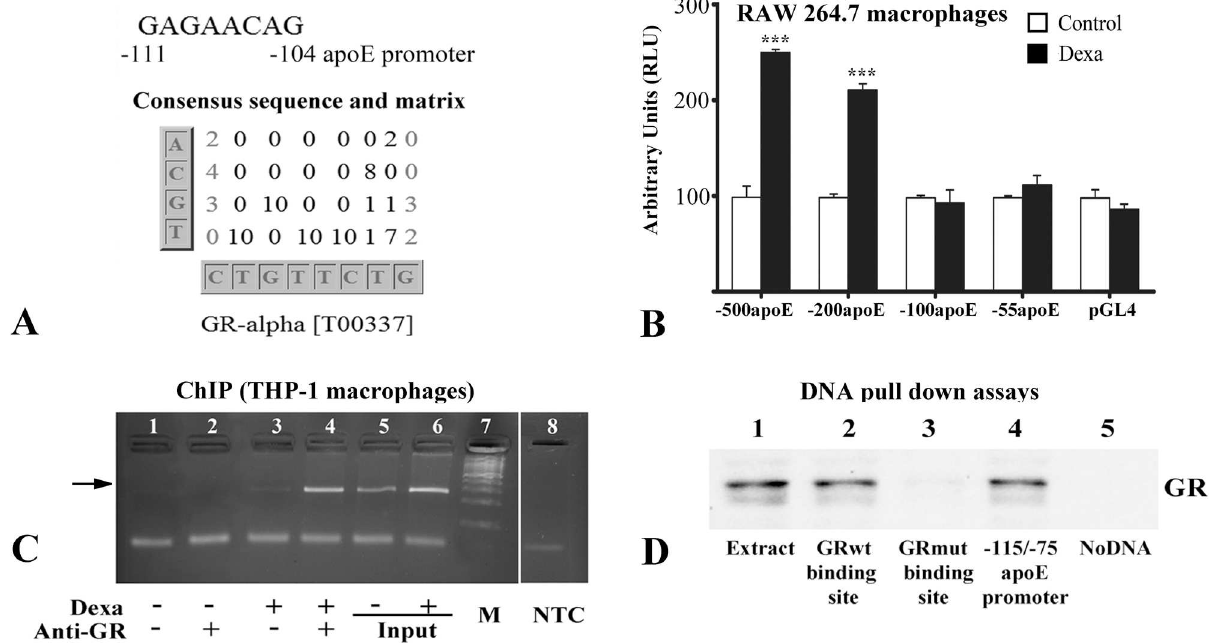
Fig 6. In macrophages glucocorticoid receptors (GRs) bind to a consensus sequence in apoE proximal promoter and upregulate its activity. (A) In silico analysisof apoE proximalpromoter revealing a GR α bindingsite in the region-111 ! -104.(B) In transiently transfected RAW 264.7 macrophages, dexamethasone significantly enhances the activity of [-500/+73] apoE promoterand of the [-200/+73] fragment, but not the activities of the [-100/+73] and [-55/+73] deletionfragments or the activity of the pGL4 vector. (C) Chromatin immunoprecipitationassay shows that GR proteins are recruited to the humanapoE promoter in PMA-differentiatedTHP1 macrophages treated with dexamethasone (lane 4). No bands were observed in untreated macrophages (lane 2) or when the antibodies were omitted (lanes 1 and 3). PCR using the input as template and primers for apoE promoter generatedthe expectedbands(lanes 5 and 6, respectively). Lane 8 representsthe no template control PCR (NTC). Specific 258 bp PCR product is indicatedby the arrow. (D) GR proteins bind efficiently to oligonucleotides corresponding to the -115/-75regionof apoE promoter as revealedby DNA pull-down assays (lane 4). GR proteins also bind to control oligonucleotides containing a known glucocorticoid responsiveelement (lane 2), but do not bind to the mutated glucocorticoid responsiveelement(lane 3). Whole cell extract was used as positive control (lane 1); there is no bindingof GRs to uncoupled Dynabeads,used as negativecontrol (lane 5). The symbol *** is for p < 0.001.